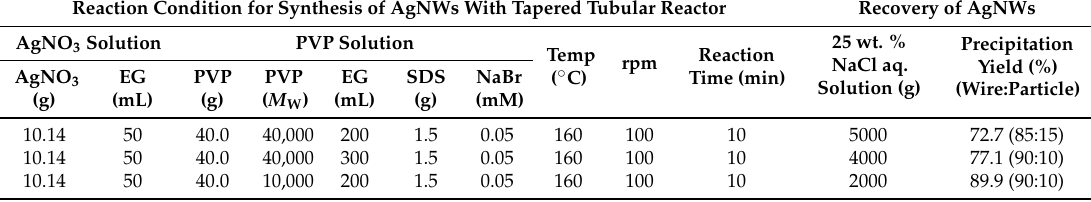
Table 5. Recovery of AgNWs from AgNW/EG reaction mixture by continuous flow reactor. Reaction Condition for Synthesis of AgNWs With Tapered Tubular